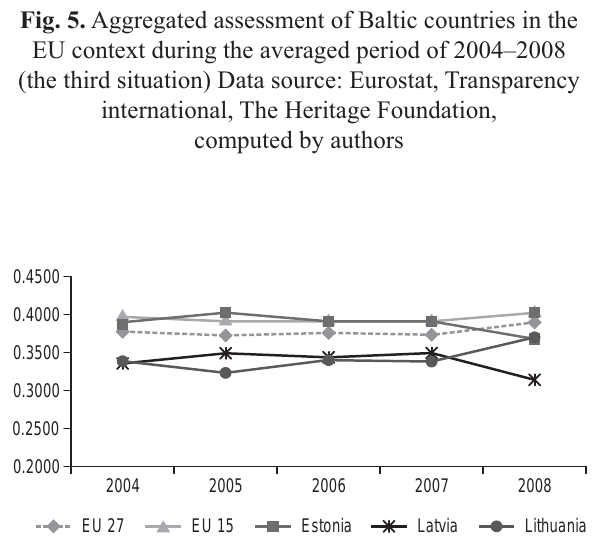
Fig. 6 . Dynamics of aggregated assessment of Baltic countries in the EU context by MPC method during the period of 2004–2008 (the third situation). Data source: Eurostat, Transparency international, The